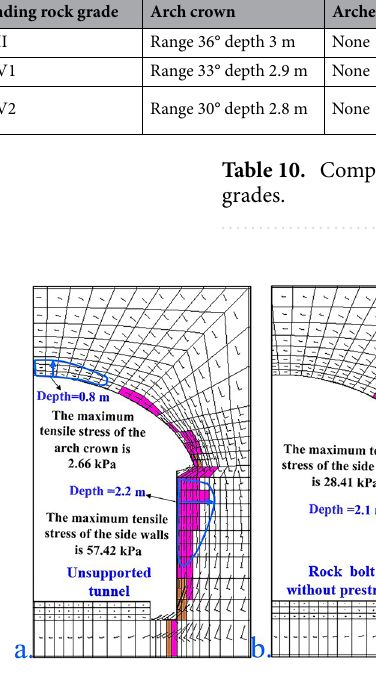
Figure 16. Rock bolts and prestressed plastic zone diagram of grade-IV2 pores. ( a ) unsupported tunnel; ( b ) rock bolt without prestress; ( c ) prestress of 40 kN; ( d ) prestress of 80 kN; ( e ) prestress of 100